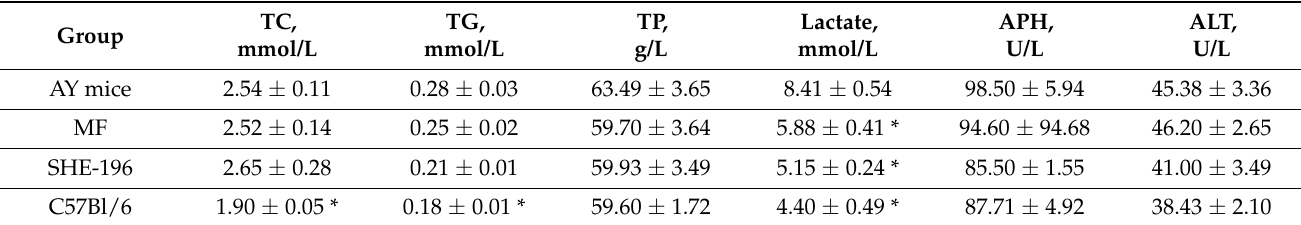
Table 3. Blood biochemical parameters of AY mice treated for three weeks by SHE-196 at a dose of 15 mg/kg and MF at a dose of 250 mg/kg. TC—total cholesterol, TG—triglycerides, TP—total protein, APH—alkaline phosphatase, ALT—alanine